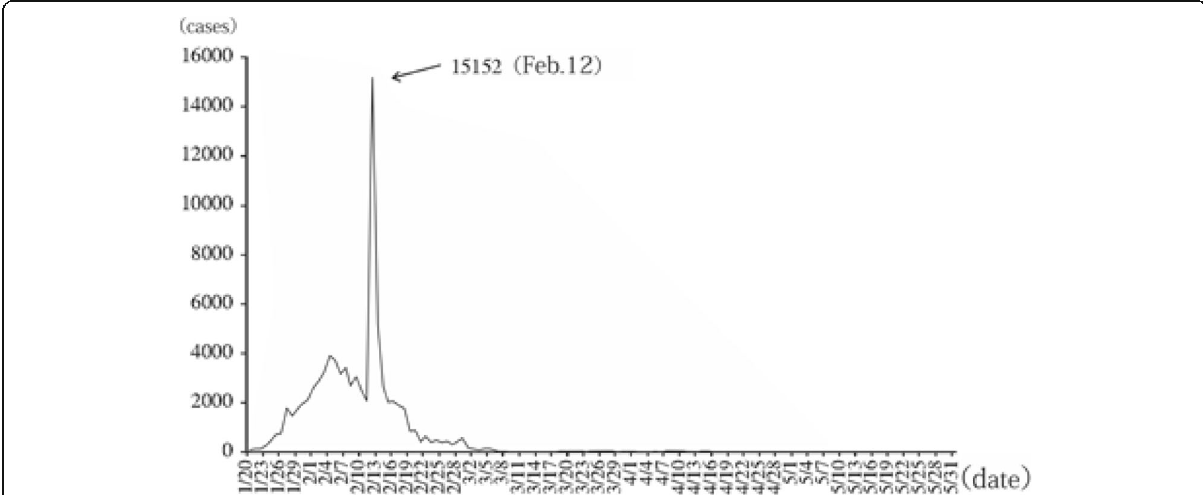
Fig. 1 Daily Confirmed New Cases within Mainland China. Data source: Fighting COVID-19: China in Action, Available from http://www.xinhuanet.